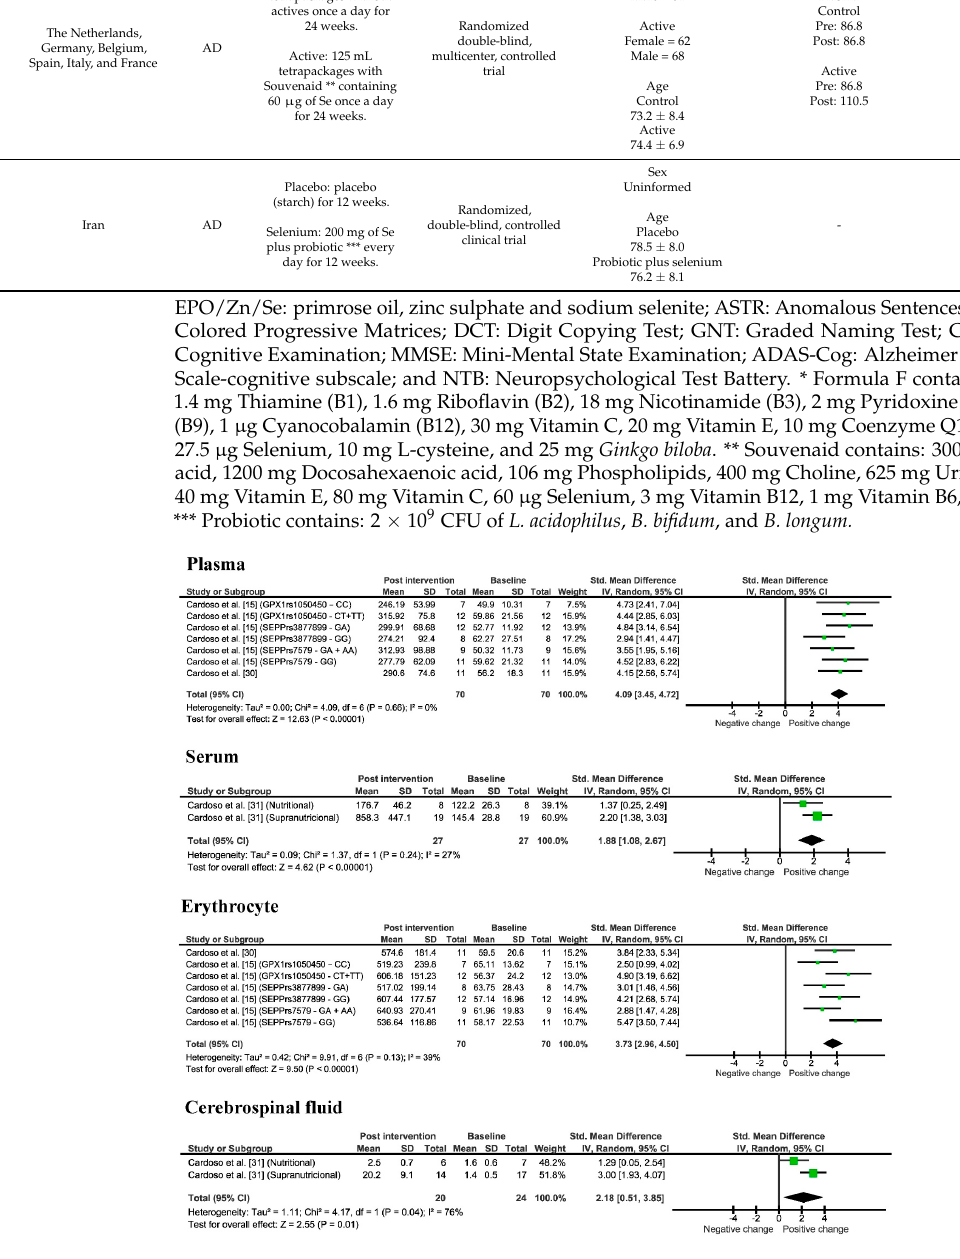
Figure 4. Meta-analysis of Se levels in plasma, serum, erythrocyte, and CSF observed in only selenium supplementation studies pre and post Se supplementation. AD: Cardoso et al. [31]/MCI: Car- doso et al. [30]; Cardoso et al. [15]. For the Se plus other nutrients studies, 42.9% of the systematically selected papers analyzed Se levels in plasma, while the other studies (57.1%) did not analyze Se levels. The Se plasma concentration before supplementation was 86.8 μ g/L and increased to 102.6–110.5 μ g/L after Se supplementation (Table 2). These results were presented as me- dians, and it was not possible to perform the meta-analysis for this parameter. 3.6. Oxidative Stress Regarding the oxidative stress analysis, 40% of the studies that evaluated only Se supplementation measured the malondialdehyde (MDA) levels in plasma. It was ob- served that the range of plasma MDA levels before Se supplementation was 0.4–0.5 μ mol/L, whereas after supplementation it was 0.5–0.6 μ mol/L (Supplementary Table S2). The meta-analysis (Figure 5) revealed that after Se supplementation MDA levels increased significantly by an average of 0.95 (0.44, 1.45) times ( p = 0.0002). Regarding the papers included in the Se plus other nutrients supplementation, 28.6% analyzed MDA levels in plasma; before supplementation, the range of plasma MDA levels was 1.2–2.6 μ mol/L